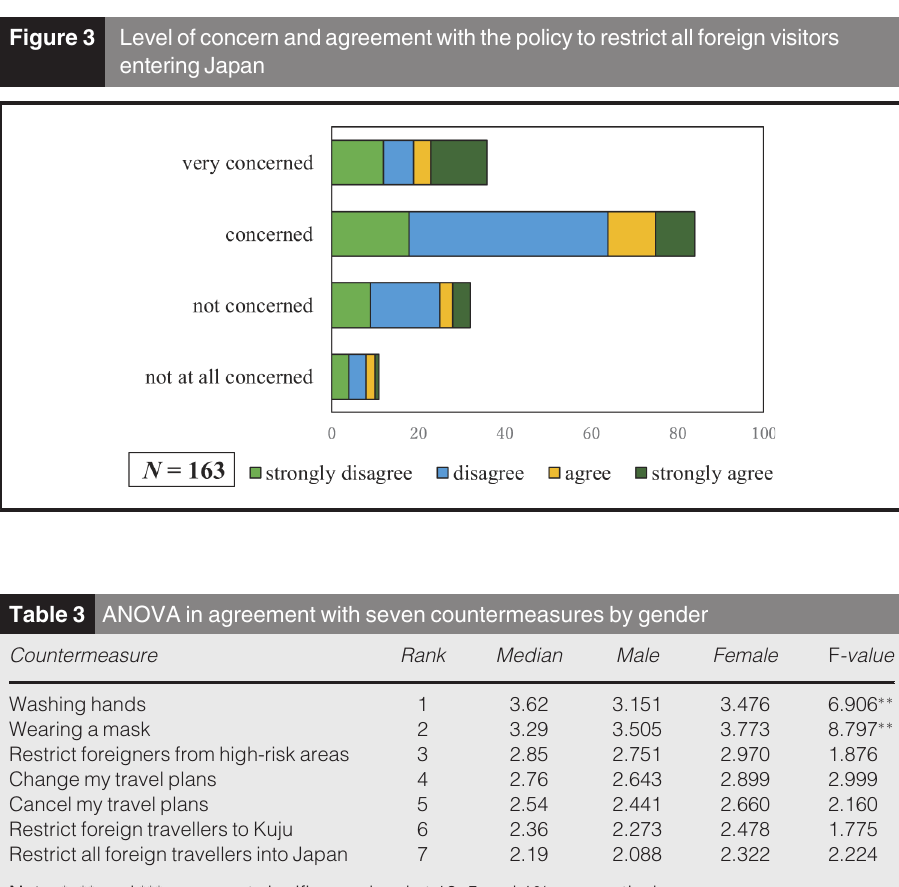
Gender Stay Intercept Male One night b b b 0 1